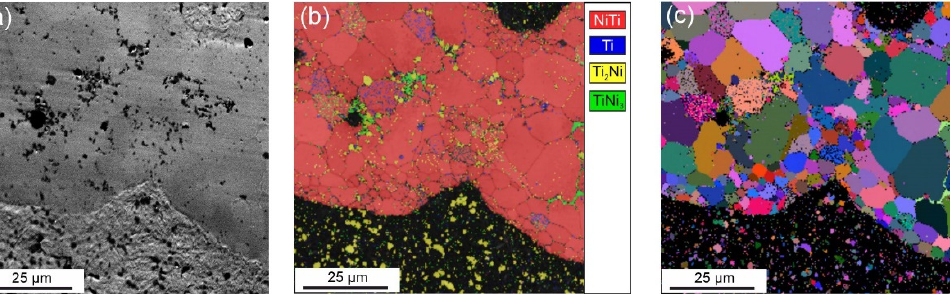
Figure 7. Orientation maps of crystals obtained on the cross section of the interpore bridge of the porous NiTi-(N) sample: ( a ) SEM image of the matrix of the porous NiTi-(N) sample, ( b ) phase map, ( c ) orientational color map at the Euler angle.